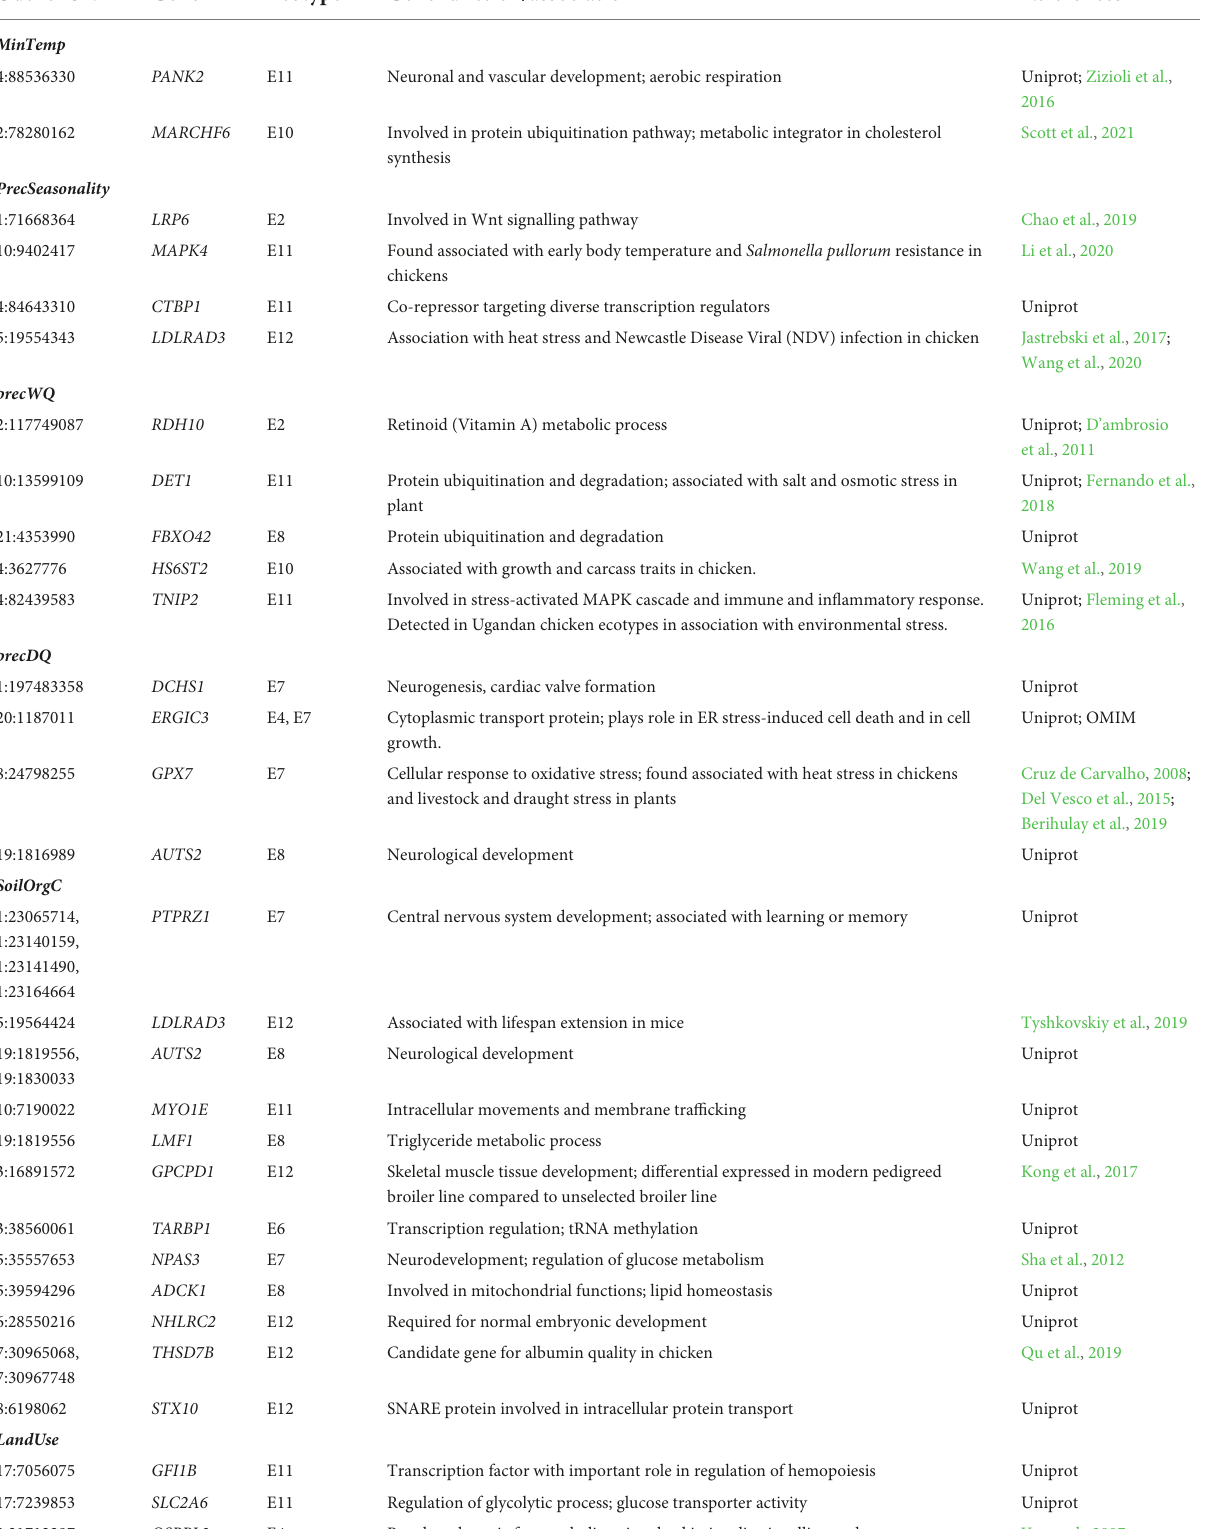
TABLE 2 Selected RDA SNPs outliers overlapping protein-coding genes. Outlier SNP Gene Ecotype* Gene function/association